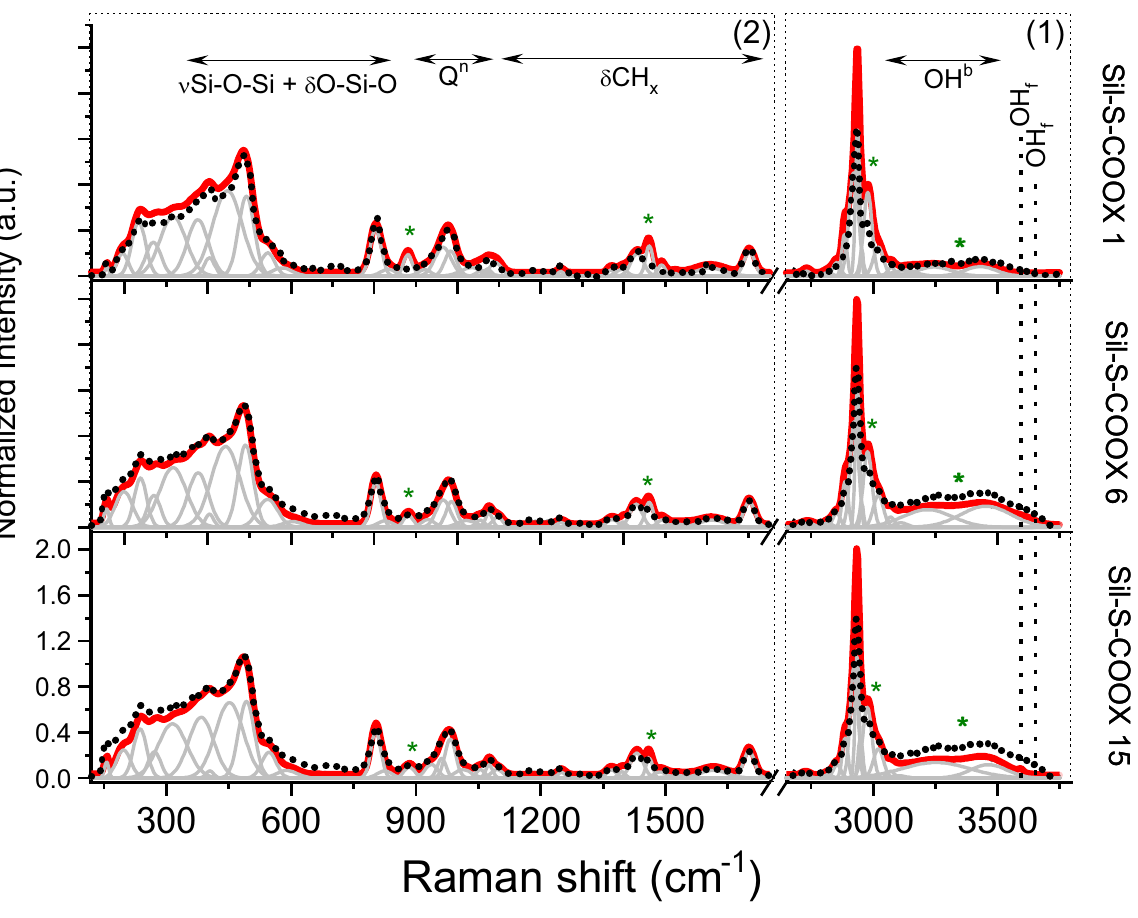
Figure 6. Raman spectra of Sil-S-COOX samples with different concentrations of active units, while X = H or 2-naphthalene methanol. Spectra of reference samples (not containing 2-naphthalene methanol) are presented as dotted lines, while 2-naphthalene methanol-activated silica as continuous red lines. Raman spectra were normalized to better illustrate the differences between the reference and activated samples. Additionally, all spectra were fitted using the Voigt function with the preservation of a minimum number of components. Green stars indicate spectral modifications after the silica functionalization through the 2-naphthalene